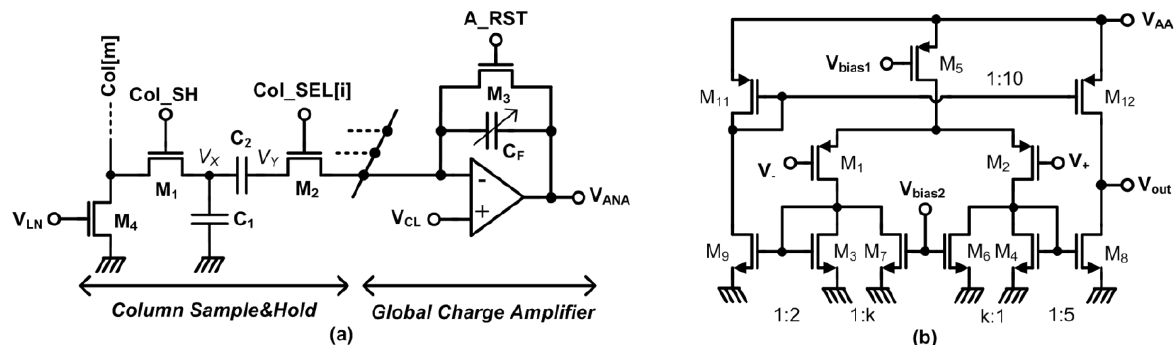
Figure 5. ( a ) Global and column level analog readout circuits; ( b ) current mirror OTA schematic used in global charge